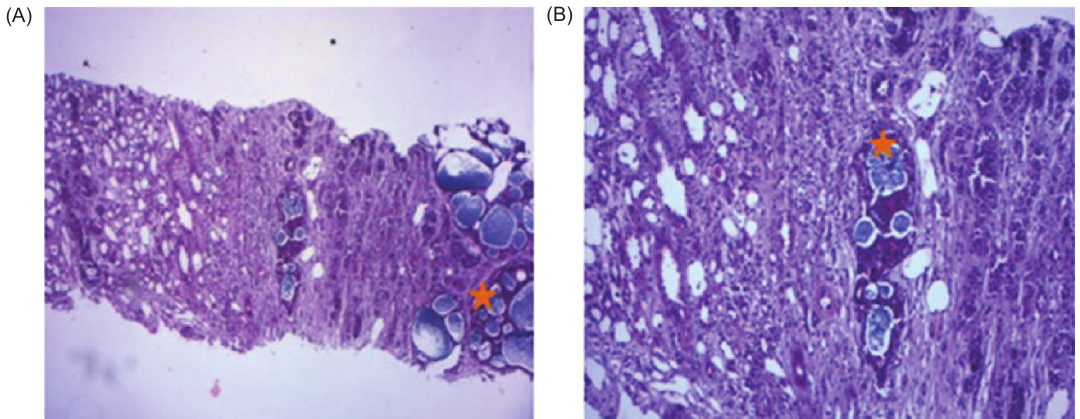
Figure2: (A) H&E photomicrographs showing renal localization of adenoid cystic carcinoma (*) with various growth patterns: Cribriform and trabecular, a characteristic cribriform pattern of adenoid cystic carcinoma (hematoxylin-eosin, ×100). (B) Crib- riform growth pattern displaying several prominent pseudocysts surrounded by basaloid cells (hematoxylin-eosin, ×200); Arrows indicate renal